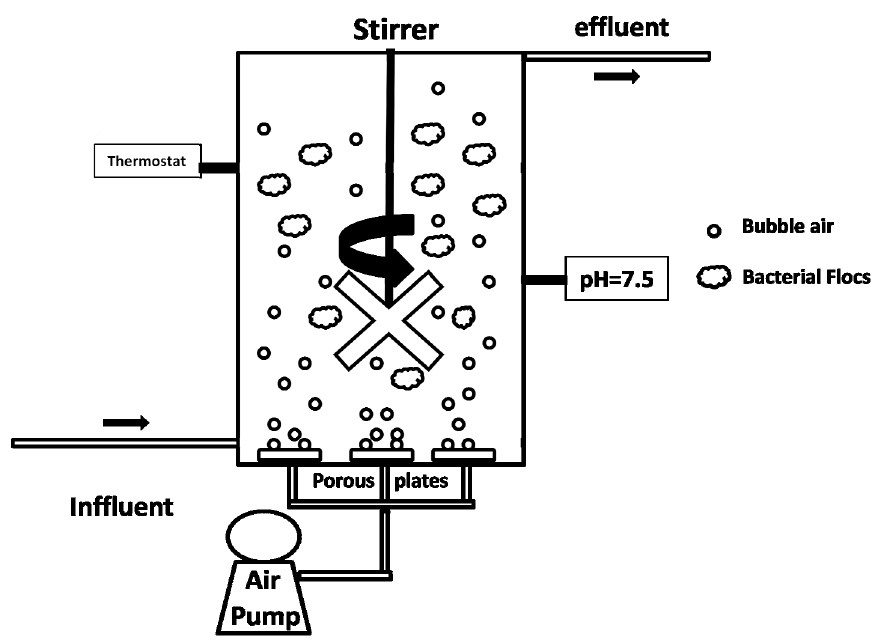
Figure 2. Schematic of a fluidized bed partial nitritation